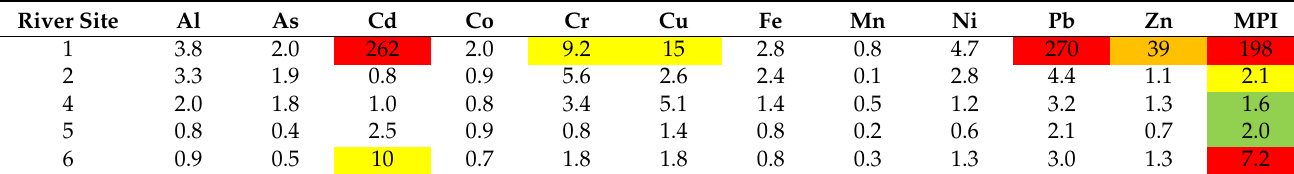
Table 5. CFs of 11 heavy metals and trace elements in plant species, and MPI at studied river sites. Legend: green, low contamination; yellow, certain/moderate pollution; orange, strong pollution; red, extreme/heavy